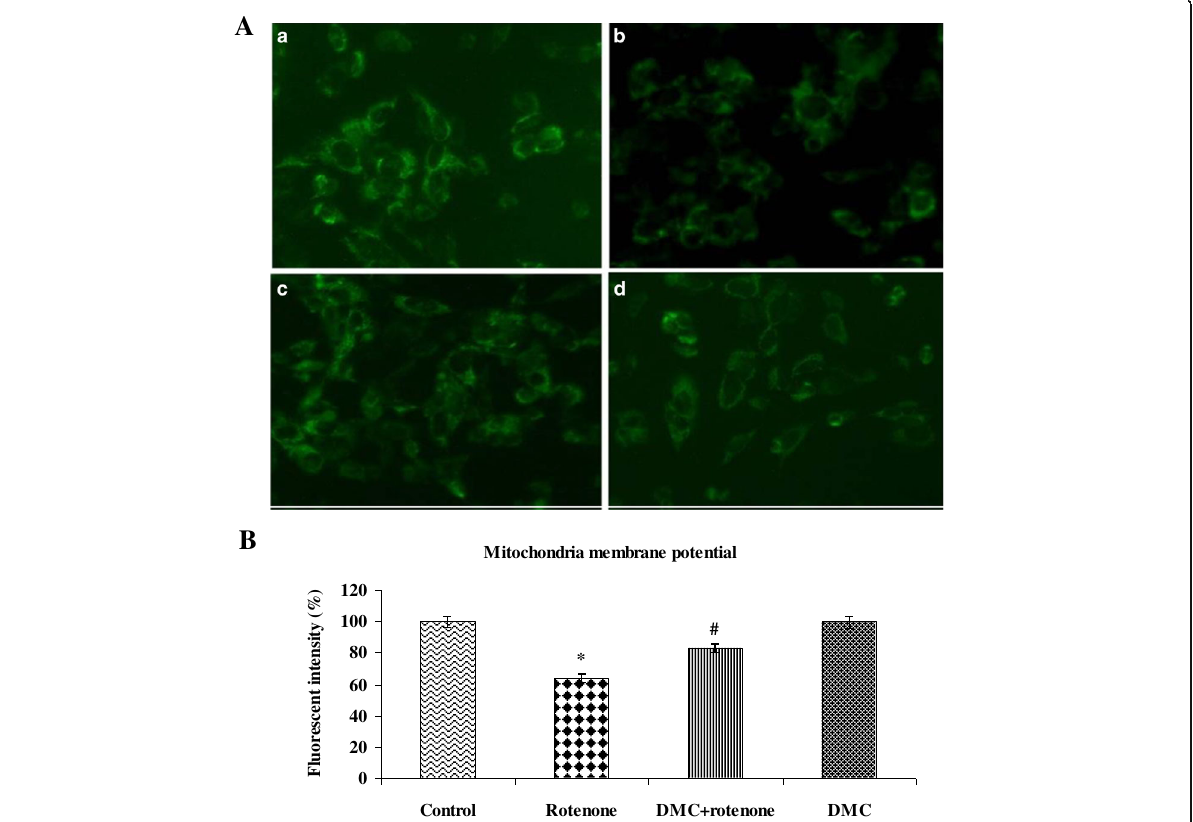
Fig. 5 DMC stabilizes MMP as stained by Rh-123. a Photomicrograph showing the preventive effect of DMC (50 nM) against rotenone induced mitochondria membrane potential. a Control, b rotenone, c DMC + rotenone and d DMC. b Rotenone (100 nM) significantly decreased MMP, while cells that were pretreated with DMC (50 nM) significantly increased MMP. Values are given as mean ± SEM of four independent experiments in each group. * p <0.05 compared to control; # p <0.05 compared to rotenone groups